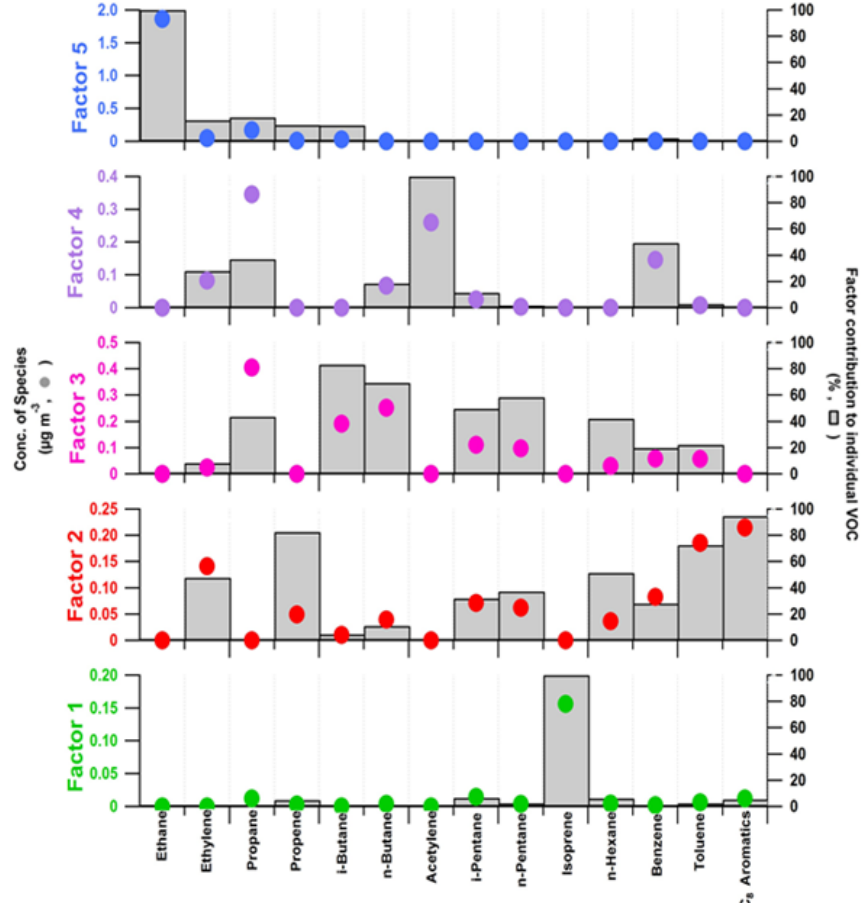
Figure 7. Chemical profiles of the five-factor PMF solution (14 variables). Factor contributions to each species (µgm − 3 ) and the percent of each species apportioned to the factor are displayed as a grey bar and a coloured circle, respectively. Factor 1 – local biogenic source; factor 2 – short-lived anthropogenic sources; factor 3 – evaporative sources; factor 4 – long-lived combustion sources; factor 5 – regional background. Table 5. Average relative factor contributions ± standard deviations (%) for the whole period and as a function of the measurement sampling time (see Table 1). Factor 2-year period Samples collected from Samples collected from 09:00 to 13:00UTC 12:00 to